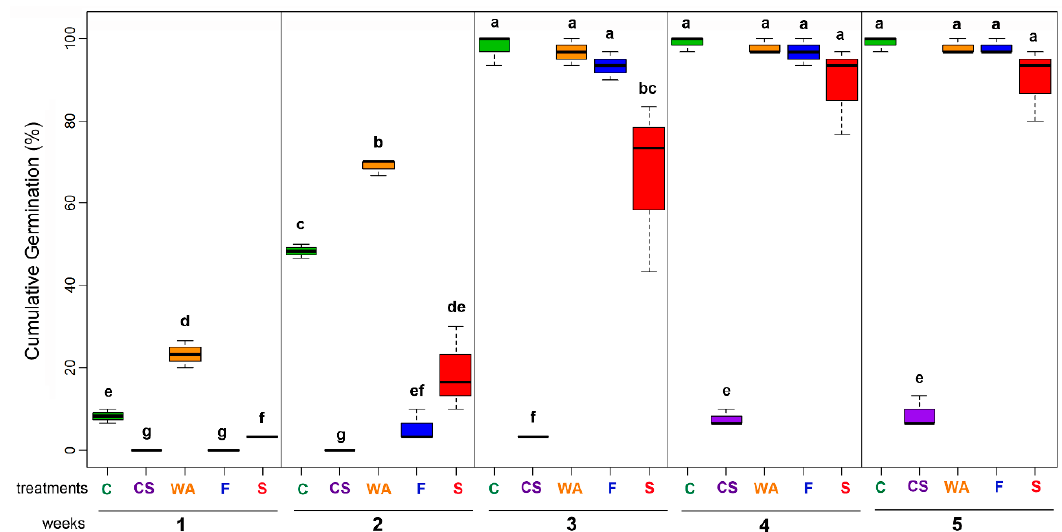
Figure 1. Cumulative germination percentage during five weeks of Physalis peruviana seeds subjected to different pre- germination treatments. C: Control (seeds without treatment, green boxes); CS: Commercial (seeds purchased from a local seller, purple boxes); WA: Wood ash (seeds after seven-day storage with wood ash, orange boxes); F: Fermentation (seeds removed after seven-day storage with pulp fruit, blue boxes); S: NaCl (a 60 mM NaCl solution supplied to the seeds three times per week, red boxes). Data expressed as median and interquartile range (n = 3). Different letters over each box indicate significant differences for each %CG according to the post-hoc Tukey test ( p < 0.05).